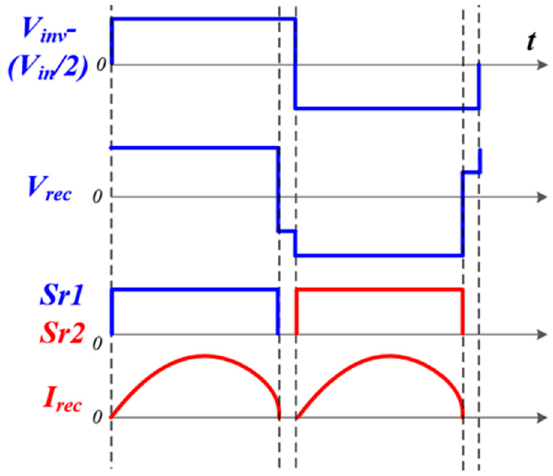
Figure 12. Operating waveforms of synchronous rectification shown in [42].